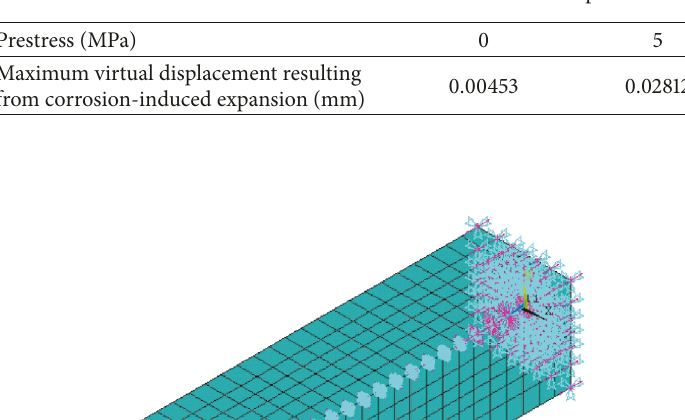
Table 1: Maximum virtual rebar displacement under five prestress conditions.